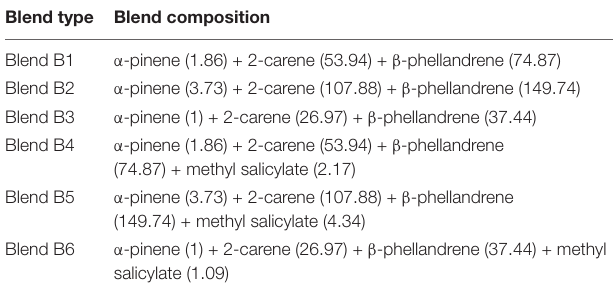
TABLE 2 | Summary of blends tested in the Y-tube olfactometer assays. Blend type Blend